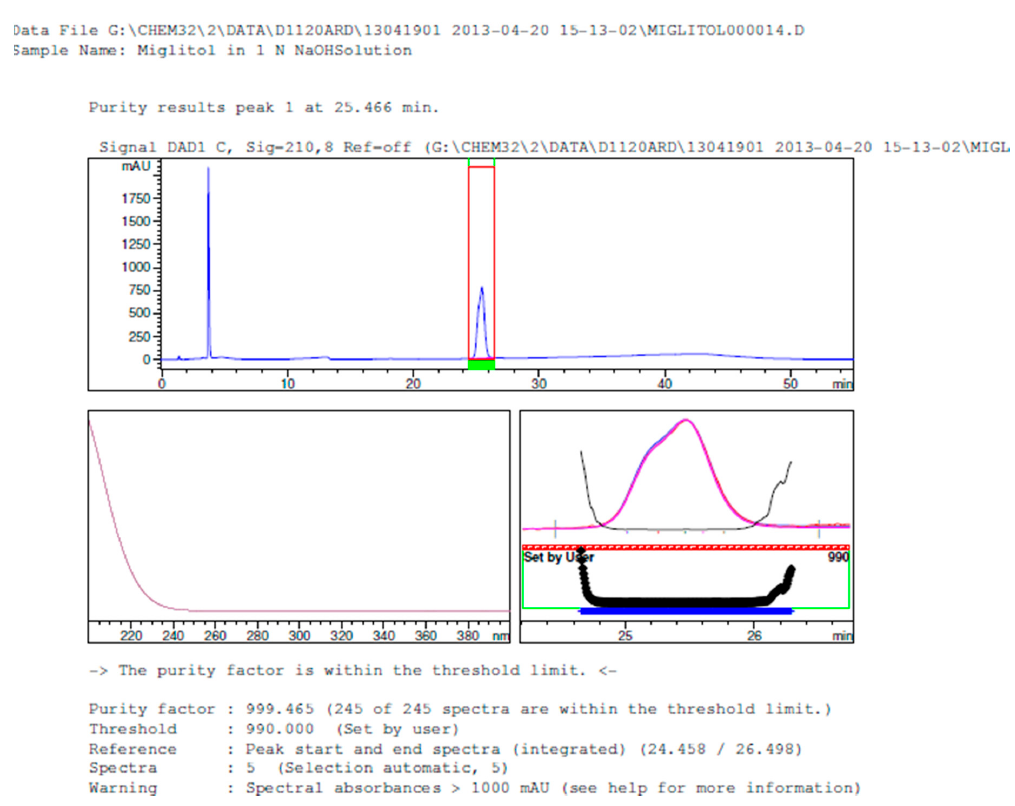
Figure 9. Peak purity in base degradation by diode array